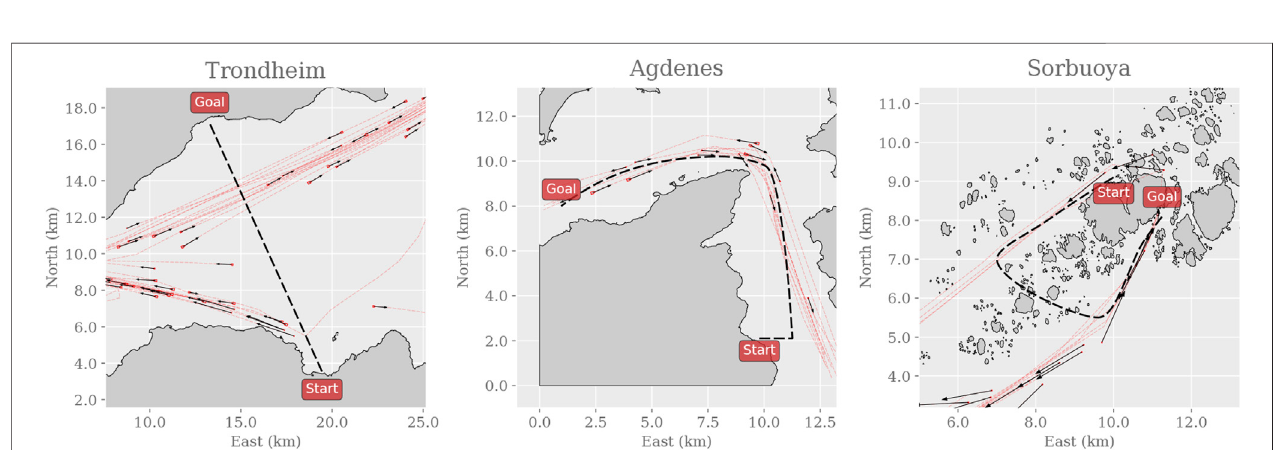
FIGURE2| Snapshotsofthethree simulatedreal-worldenvironments.Here,thepaths andthelandmassesare fi xedfor eachinstance oftheenvironment, though each instance samples arandom subset ofthe historical AIS data tocreate the dynamicobstacles. Thus, the dynamic obstacles are initialized with an initial position and velocity as shown with the black arrows and will follow the trajectories shown with the red dashed lines. As in the training environments, the agent ’ s goal is to safely navigate the vessel along the path from the starting position to the goal.